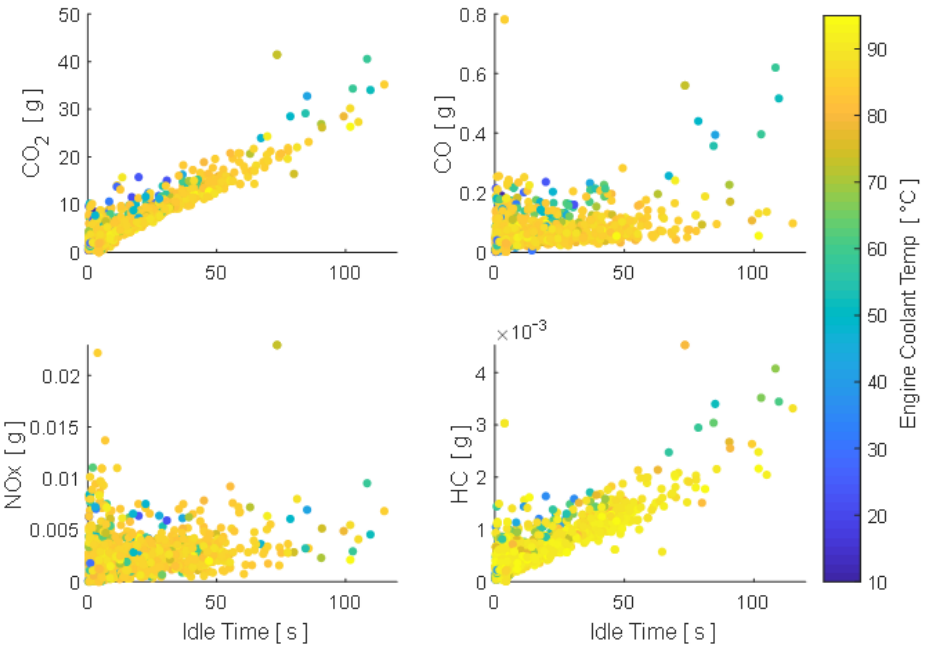
Figure 9. Pollutant emissions generated in idle